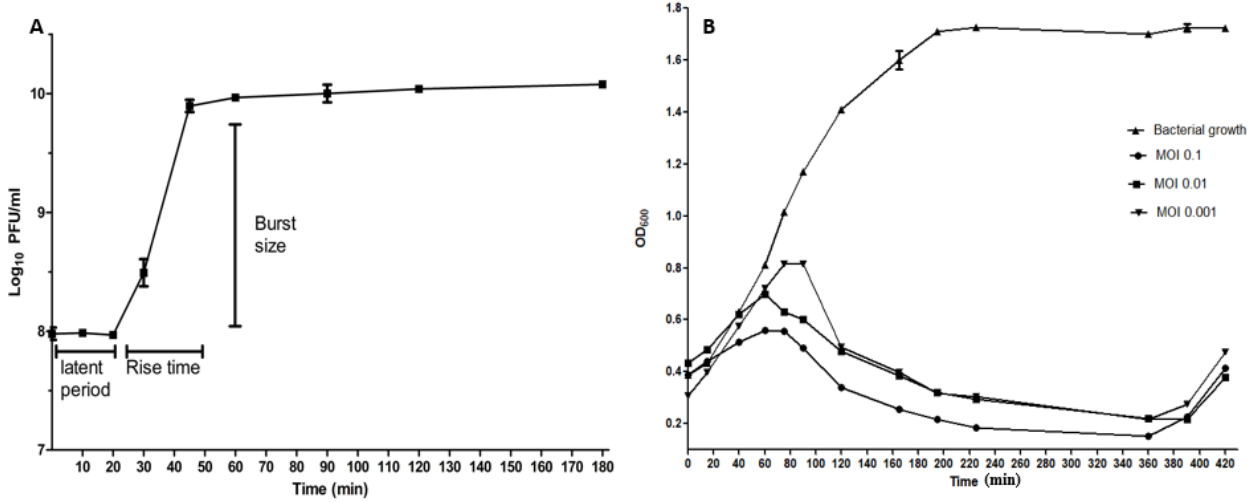
Figure 2. displays the behavior of phage ZCSE6 lysis against bacterial host. ( A ) One-step growth curve MOI of 1 and ( B ) time-killing curve with different MOIs.